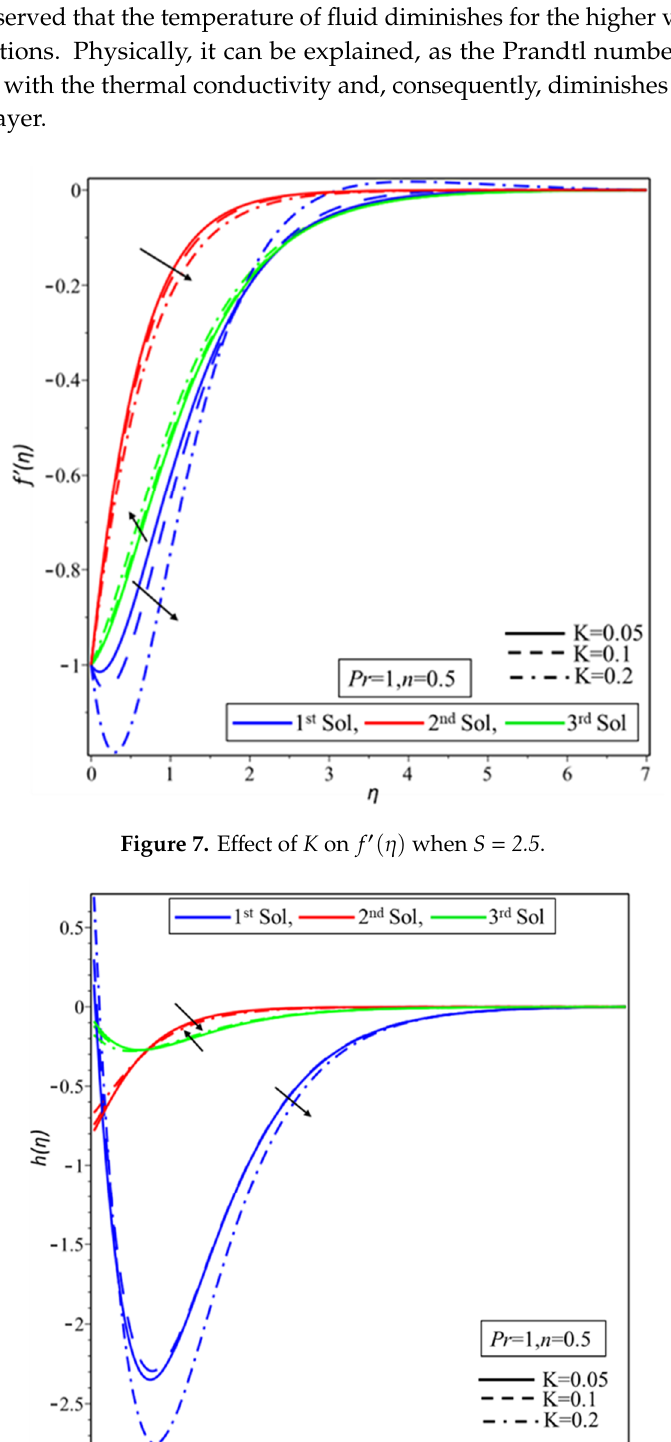
Figure 8. E ff ect of K on h ( η ) when S = 2.5 Figure 8. Effect of K on ℎ((cid:2015)) when S = 2.5 .